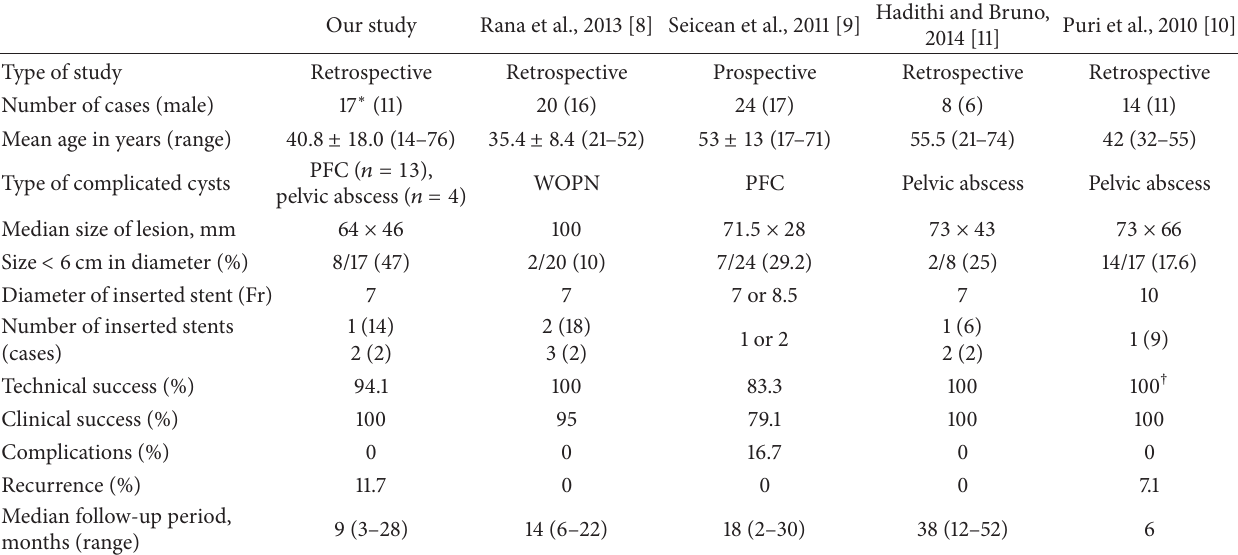
Table 2: Comparison of outcomes among five studies of endoscopic ultrasound-guided drainage of extraluminal complicated cysts without fluoroscopic